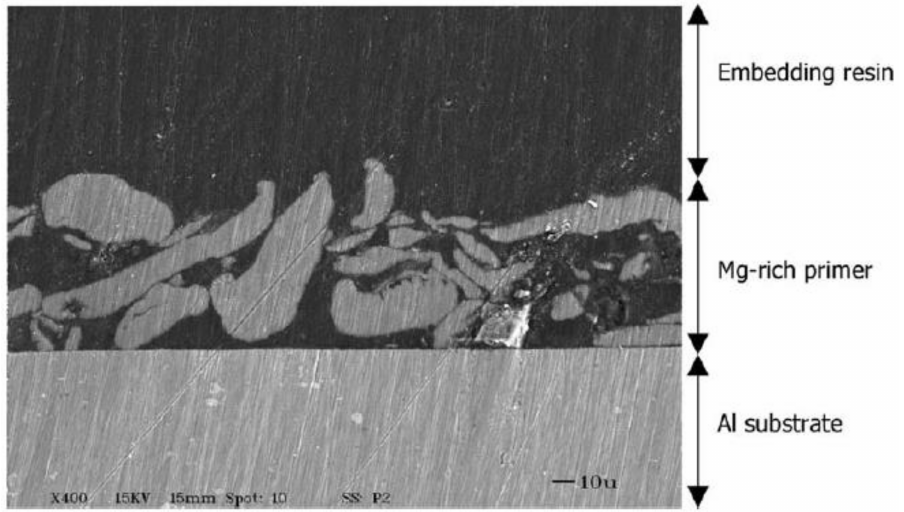
Figure 10. Cross-section micrograph of Mg-rich primer on aluminum alloy. Reprinted with permis- sion from Ref. [44]. Copyright 2006,